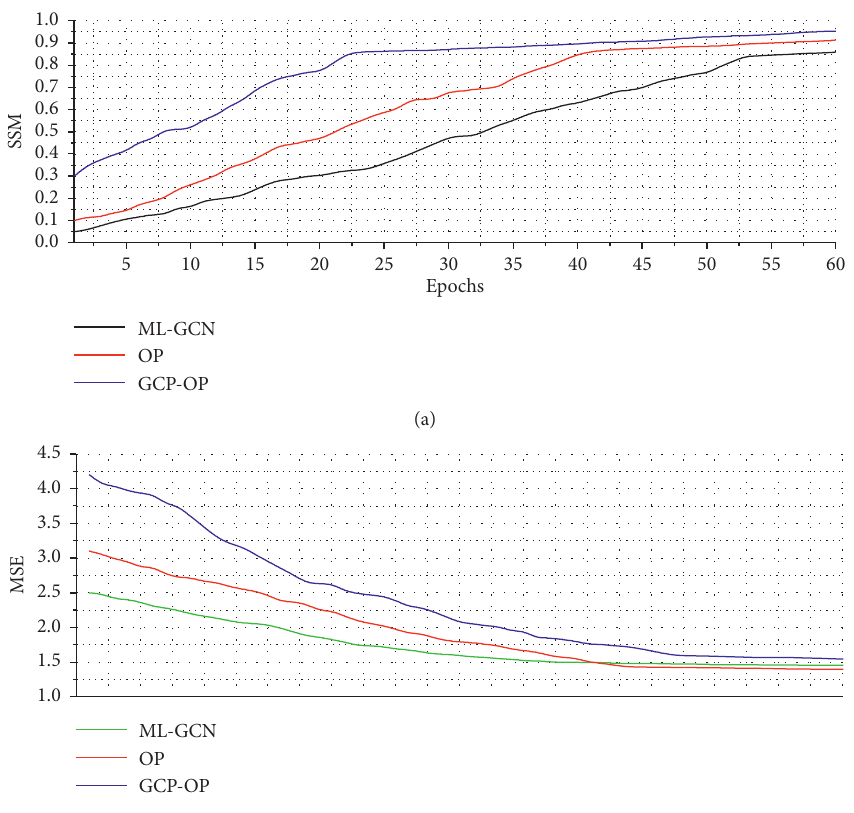
Figure 4: Comparison of ML-GCN before and after improvement algorithm and two-channel improvement algorithm for checking accuracy values.